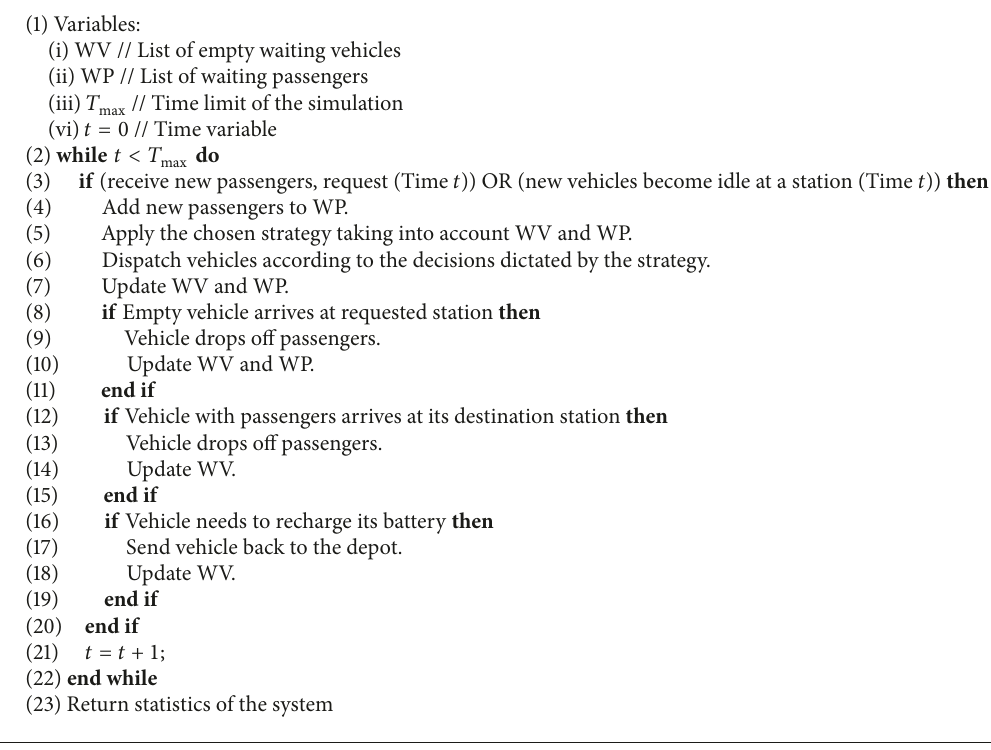
Algorithm 2: Simulation of the PRT